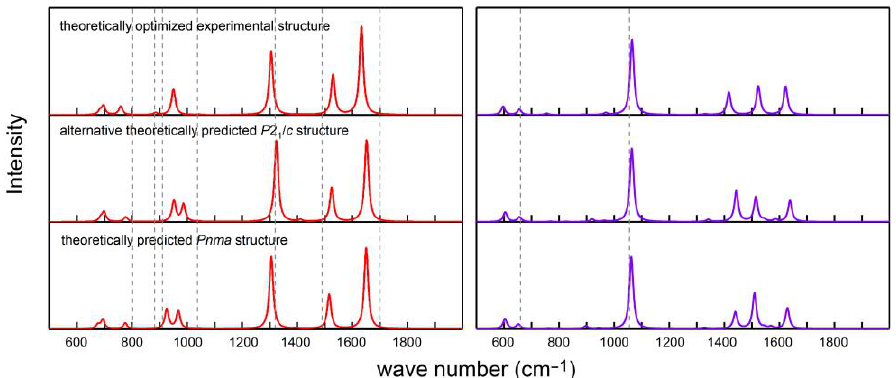
Figure A5. Calculated infrared ( left ) and Raman ( right ) spectra of H 2 CO 3 at a pressure of 2 GPa. For comparison, the positions of the experimentally determined vibrations according to the high-pressure measurements [13] interpolated to 2 GPa are indicated as dashed grey lines.